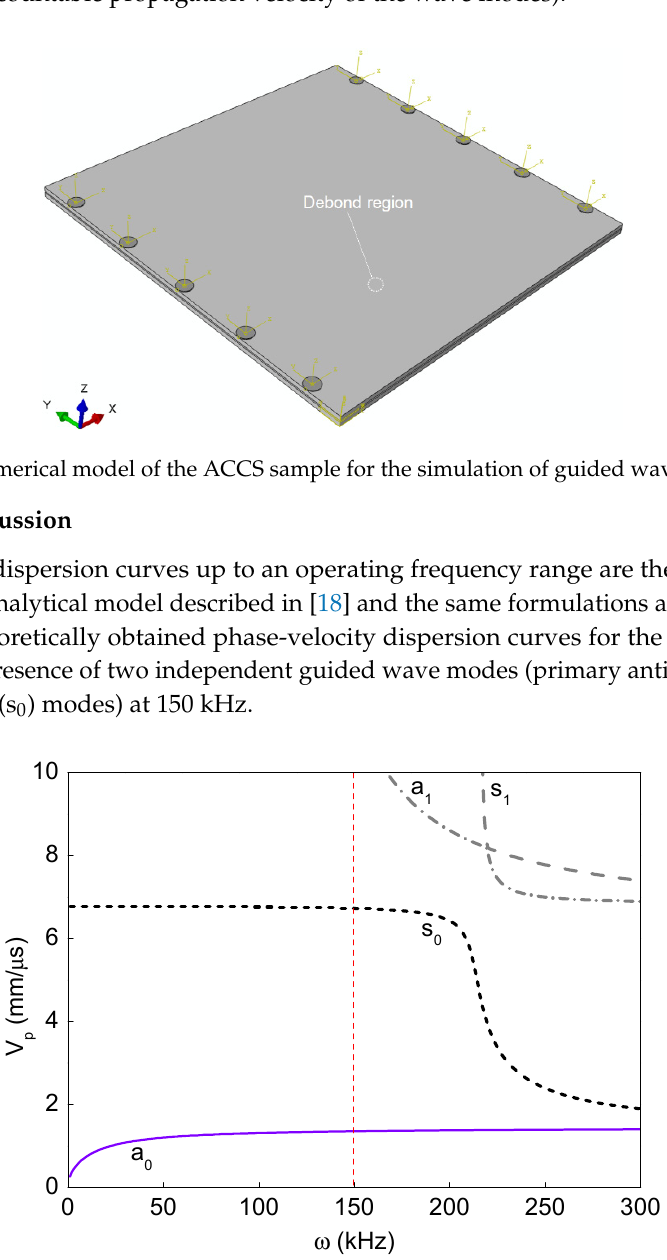
Figure 6. Dispersion curves for the guided wave propagation in the pristine ACCS at 20 °C .